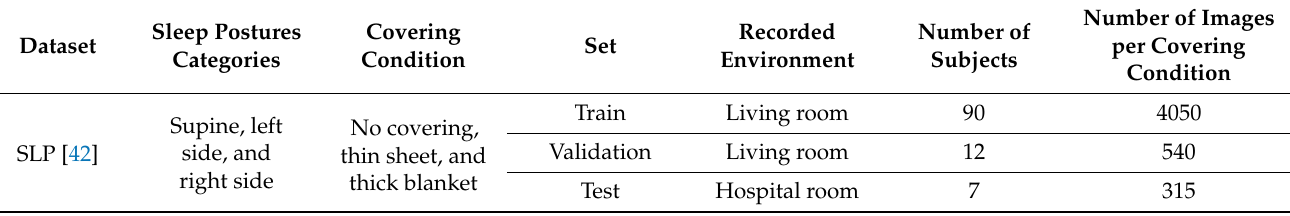
Table 3. The details of the SLP